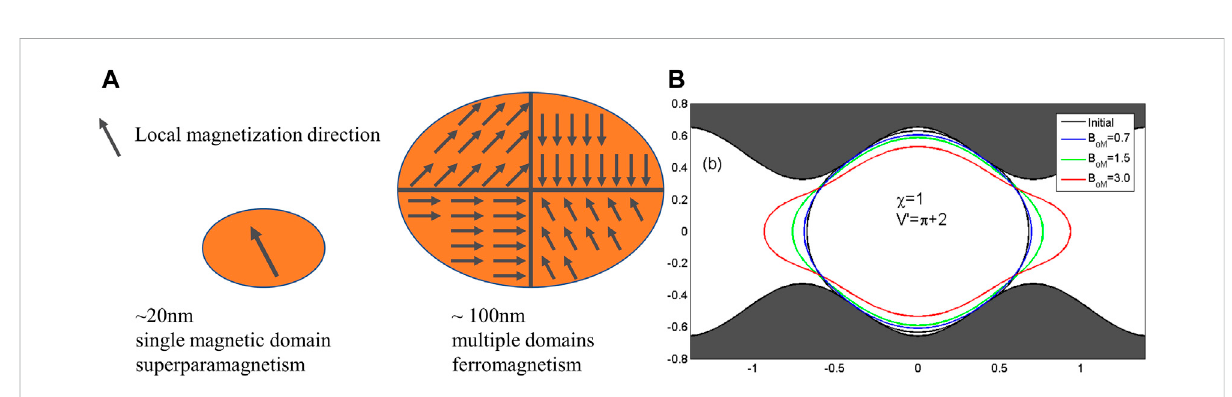
FIGURE 3 (A) Superparamagnetism and ferromagnetism (based on Wang, 2021). (B) Oil blob deformation in a pore in a magnetic fi eld parallel to the fl ow direction of ferro fl uid (Saint-Martin de Abreu Soares,